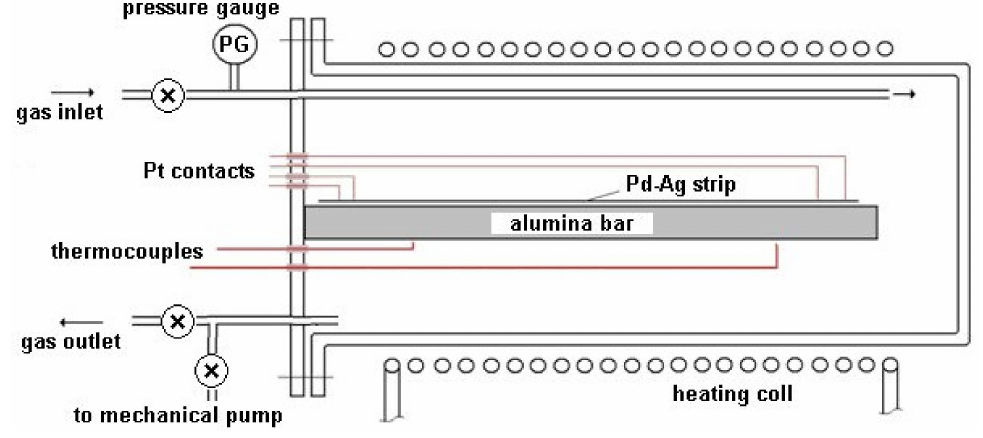
Figure 2. Experimental